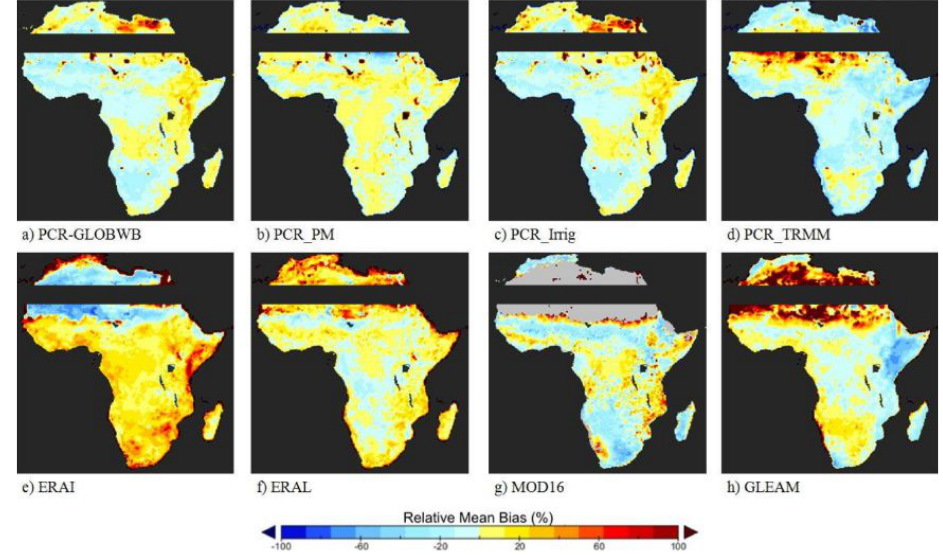
Fig. 5. Relative mean bias (RMB) between each product and the evaporation multiproduct (EM).